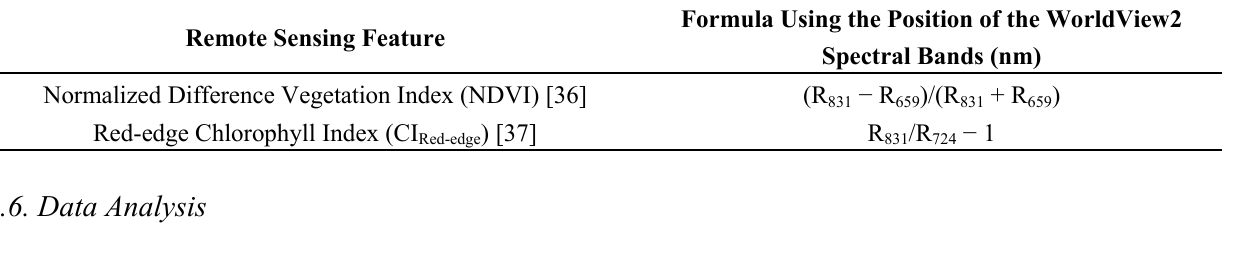
Table 3. Remote sensing vegetation indices used to estimate GCF Tamarugo